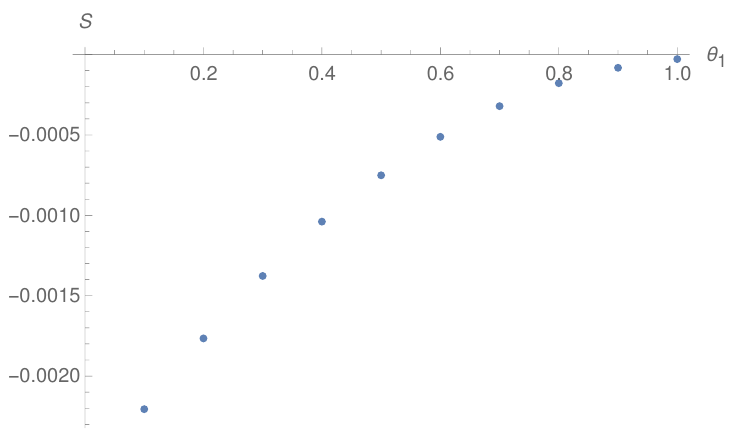
→ θ . In this 2 1 = θ = 5 π/ 5 6